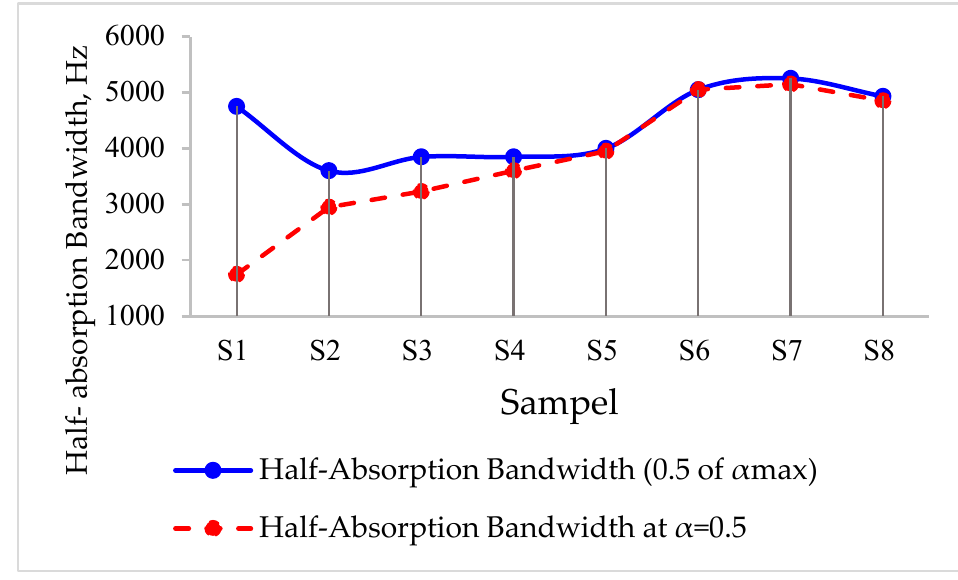
Figure 9. The trend of half-absorption bandwidth for different hole diameter and bandwidth comparison between ∆ α 0.5 = 0.5 × α max and α = 0.5.